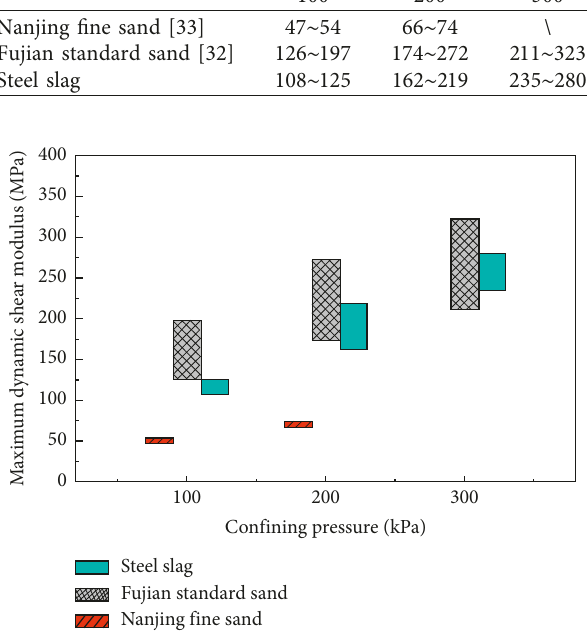
Figure 13: Comparison of the maximum dynamic shear modulus of steel slag with traditional